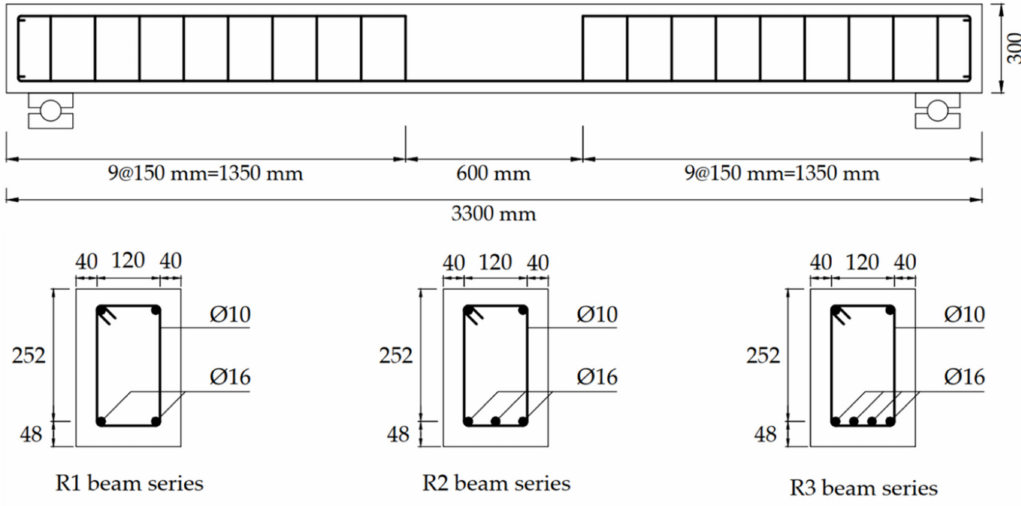
Figure 4. Dimensions of the